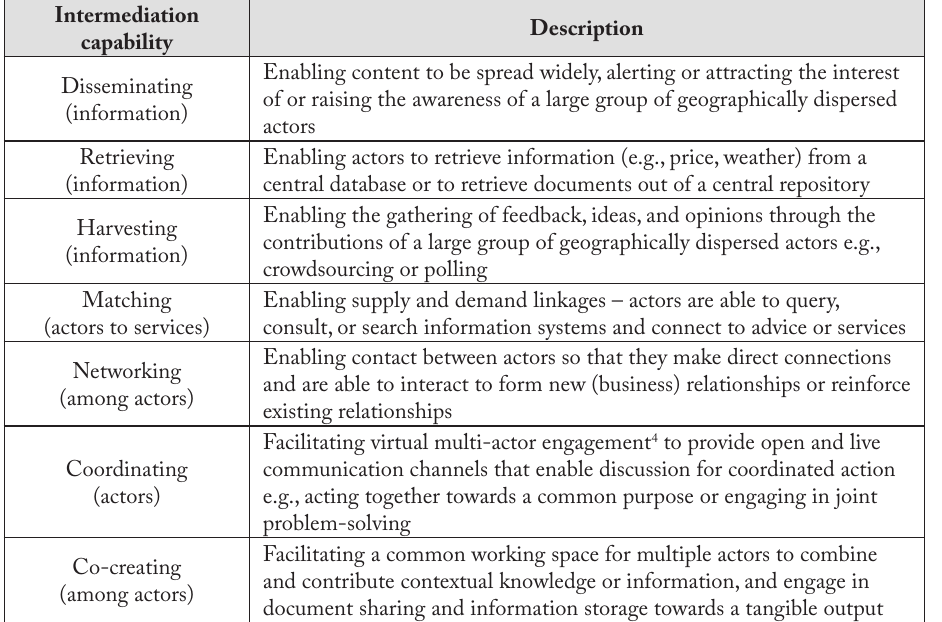
Table 1: Intermediation